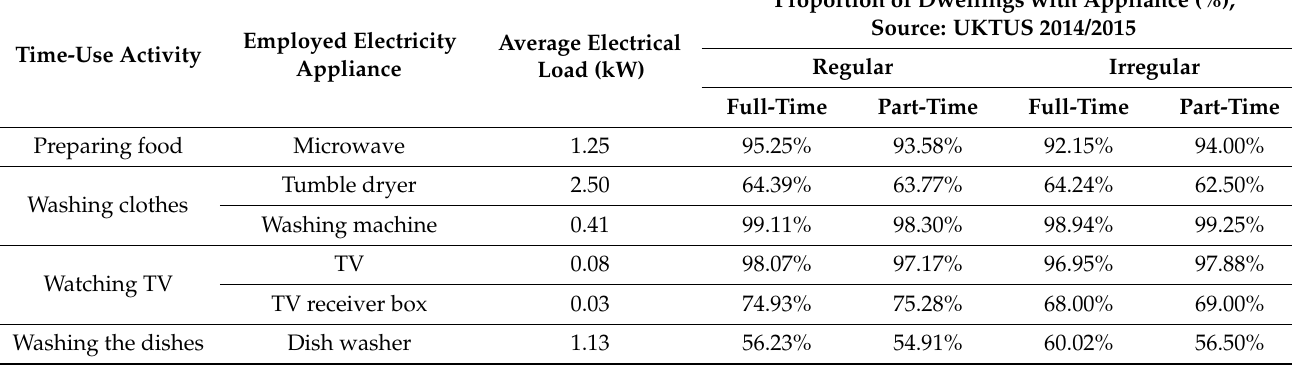
Table 2. UKTUS 2014/2015 time-use activities and associated appliances, including electrical load and proportion of dwellings with